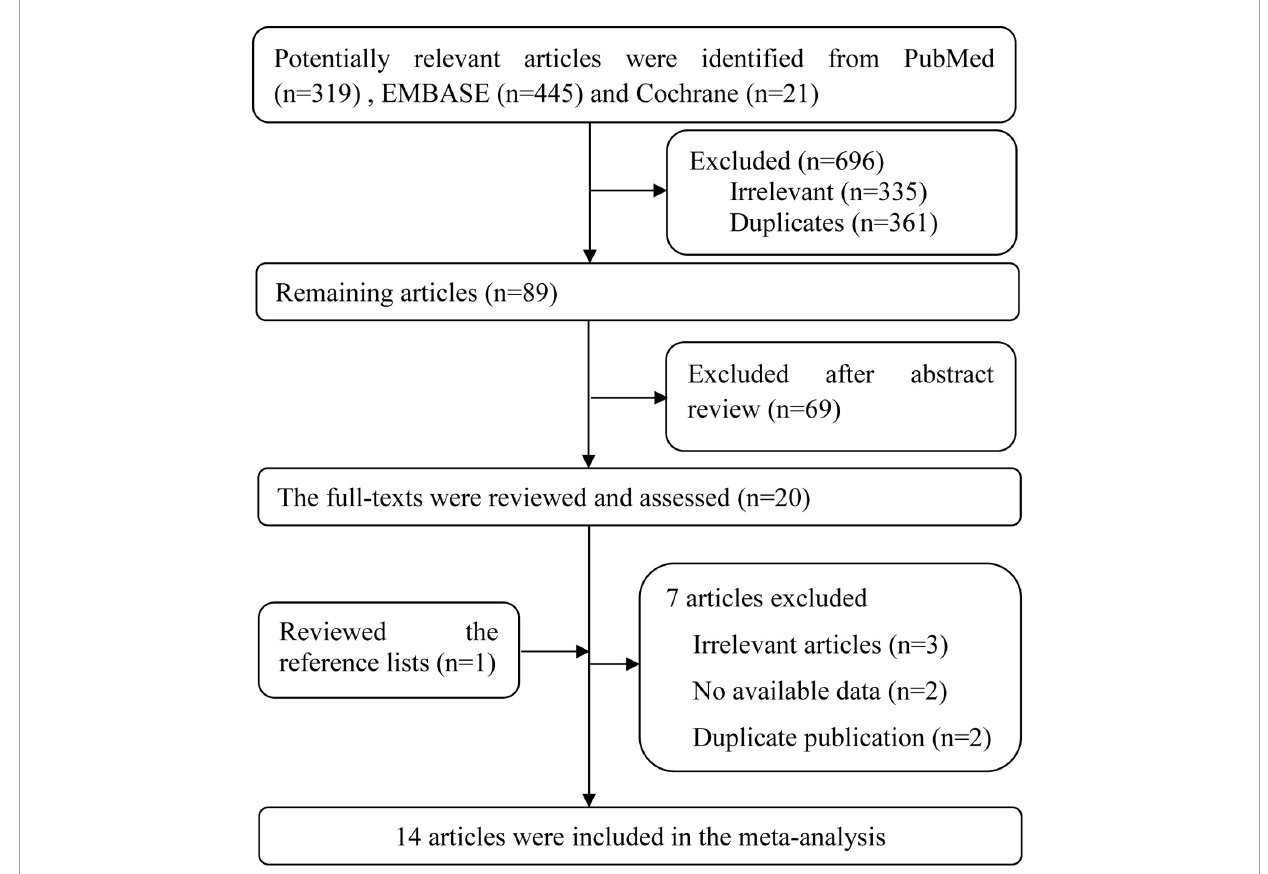
FIGURE1 Flow chart of the literature search and study selection for relevant studies in the